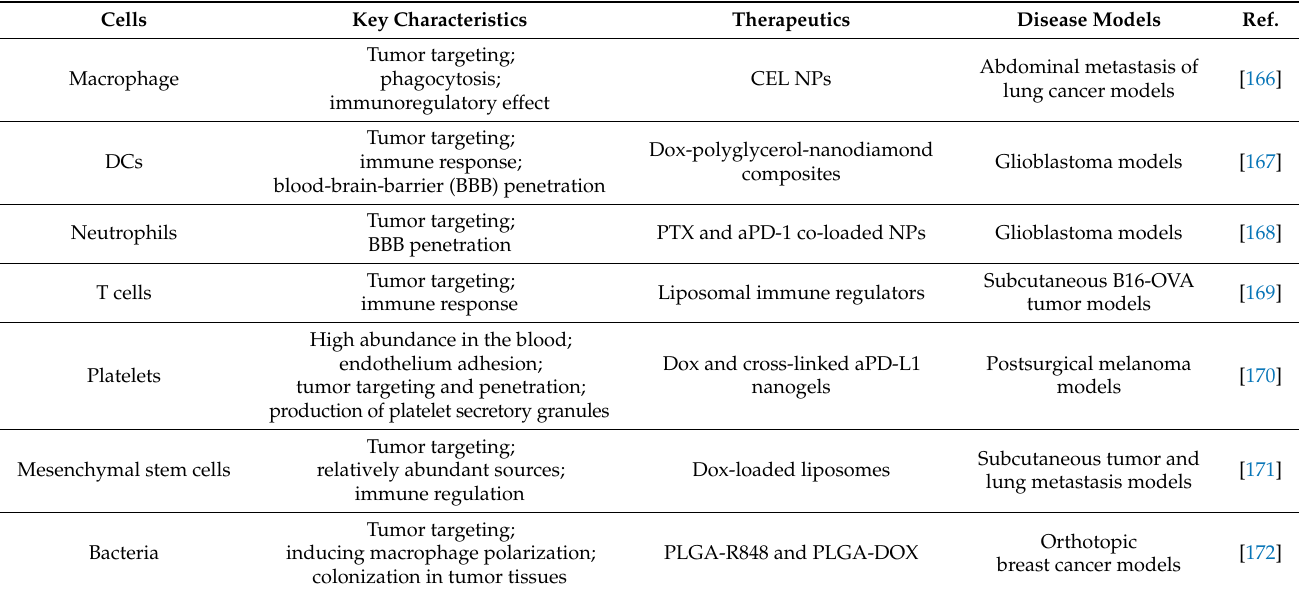
Table 2. Representative living cell-mediated nanoparticles. Key Characteristics Therapeutics Disease Models